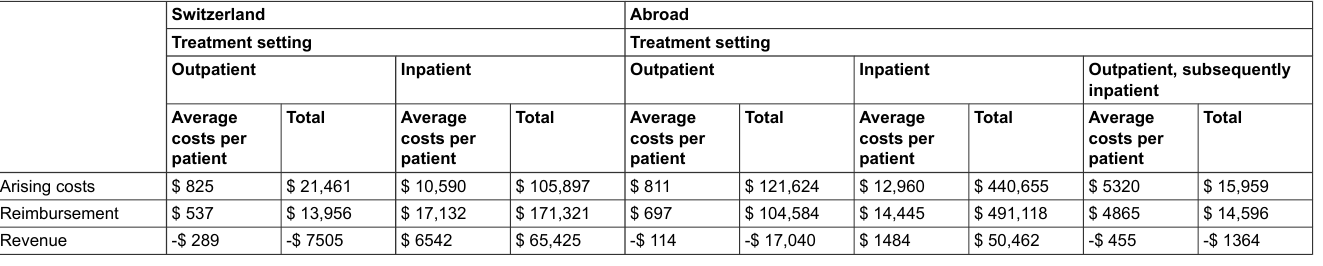
Table 4: Average costs of complications treated surgically and conservative. Switzerland Treatment